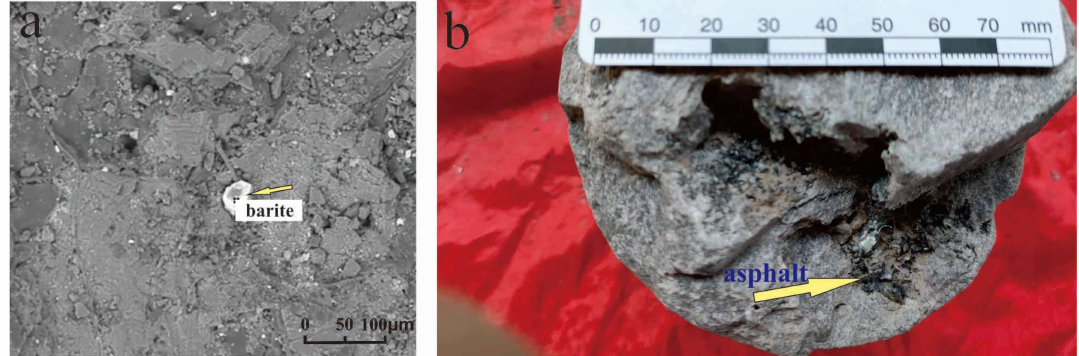
Figure 3. SEM image of barite and core image of asphalt. ( a ) Barite under SEM. ( b ) Vug filling with